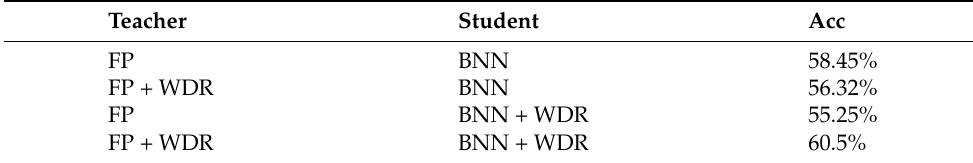
Table 4. Ablation Study—WDM scheme analysis with different training of